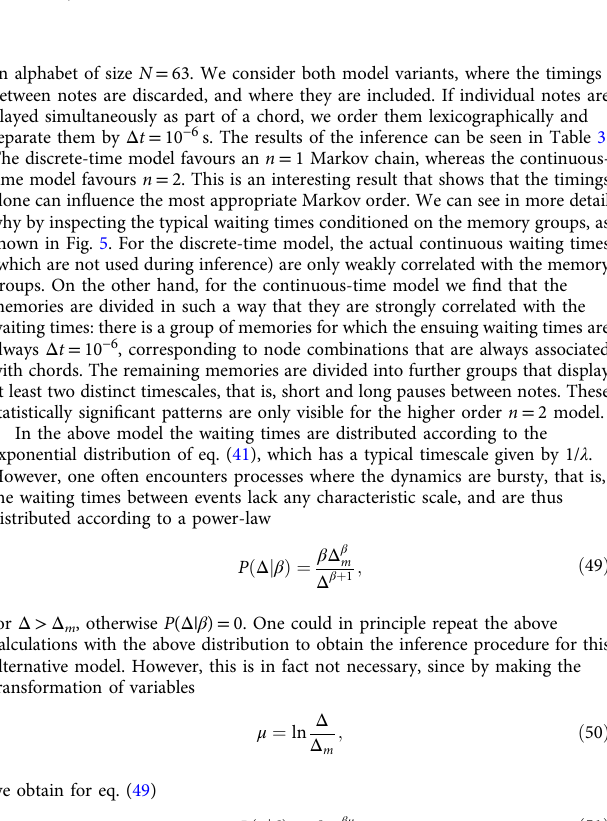
Fig. 4 Inferred temporal model for a high school proximity network 42 . a The static part of the model divides the high school students into C = 10 groups ( square nodes ) that almost match the known classes ( text labels ). b The dynamic part of the model divides the directed multigraph group pairs in a into B N = B = 9 groups ( grey circles ). The model corresponds to an n = 1 uni fi ed Markov chain on the edge labels, where the memory and tokens have identical M partitions, as described in detail in the Methods section The uni fi ed fi rst-order